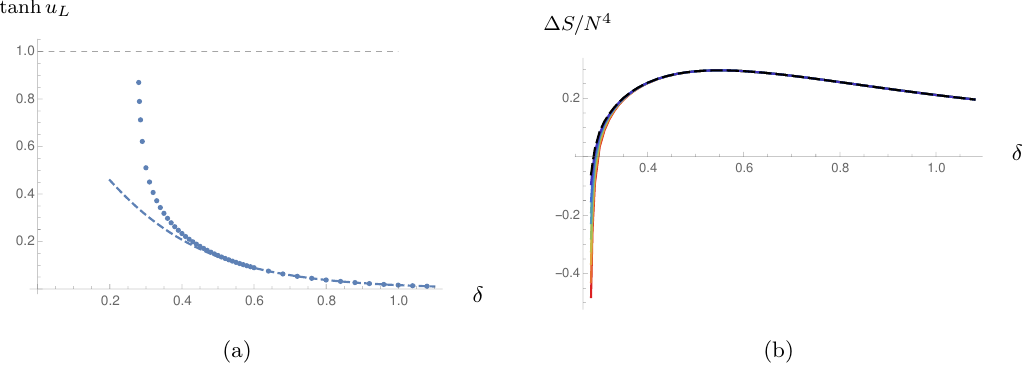
Figure 11 . Left: cap-off point u L = lim x →−∞ u ( x, y ) at x = −∞ as function of the separation of brane sources δ . For large δ , u L approaches the horizon at u = 0 exponentially; the dashed line shows u L = 1 . 17 exp( − 4 . 28 δ ) . At a finite δ c , u L diverges towards the conformal boundary (at tanh u = 1 in the plot). Right: area difference ∆ S = S island − S HM , as colored curves for different choices of cut-off on the AdS 4 radial coordinate. The dashed black curve shows an extrapolation to zero